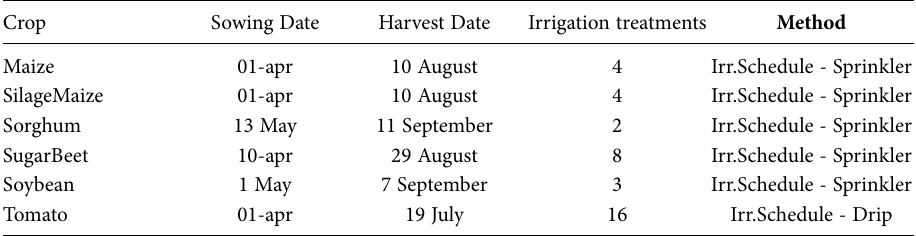
Table 2. Irrigation management hypothesized for each crop considered in simulation procedure. Crop